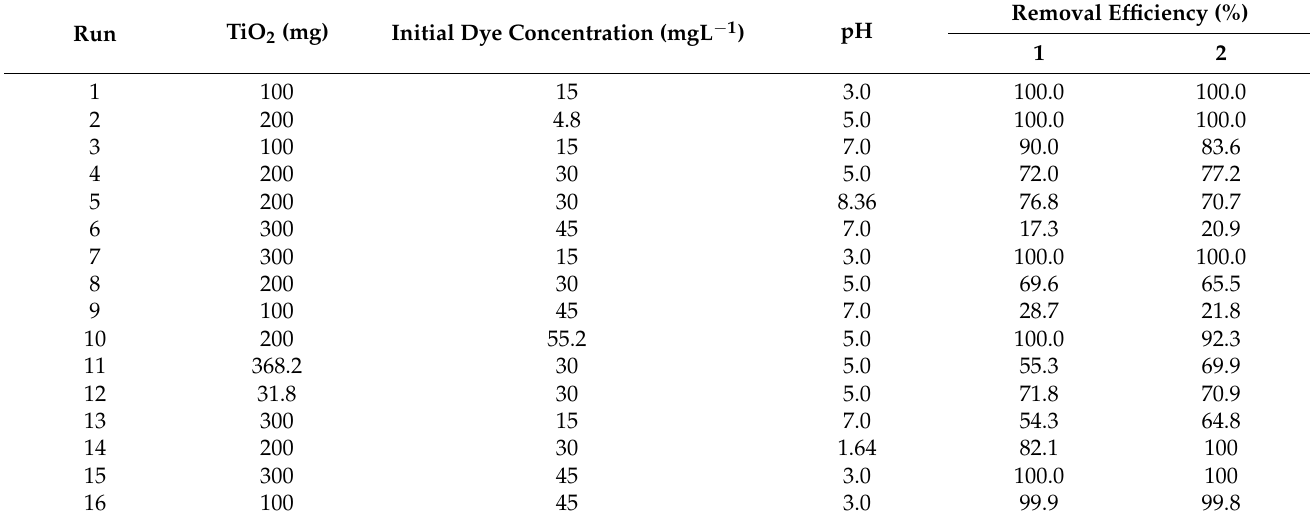
Table 3. Experimental design matrix and response matrix in the removal optimization of FD&C Red 40 dye with CS-TiO 2 - GLA beads.